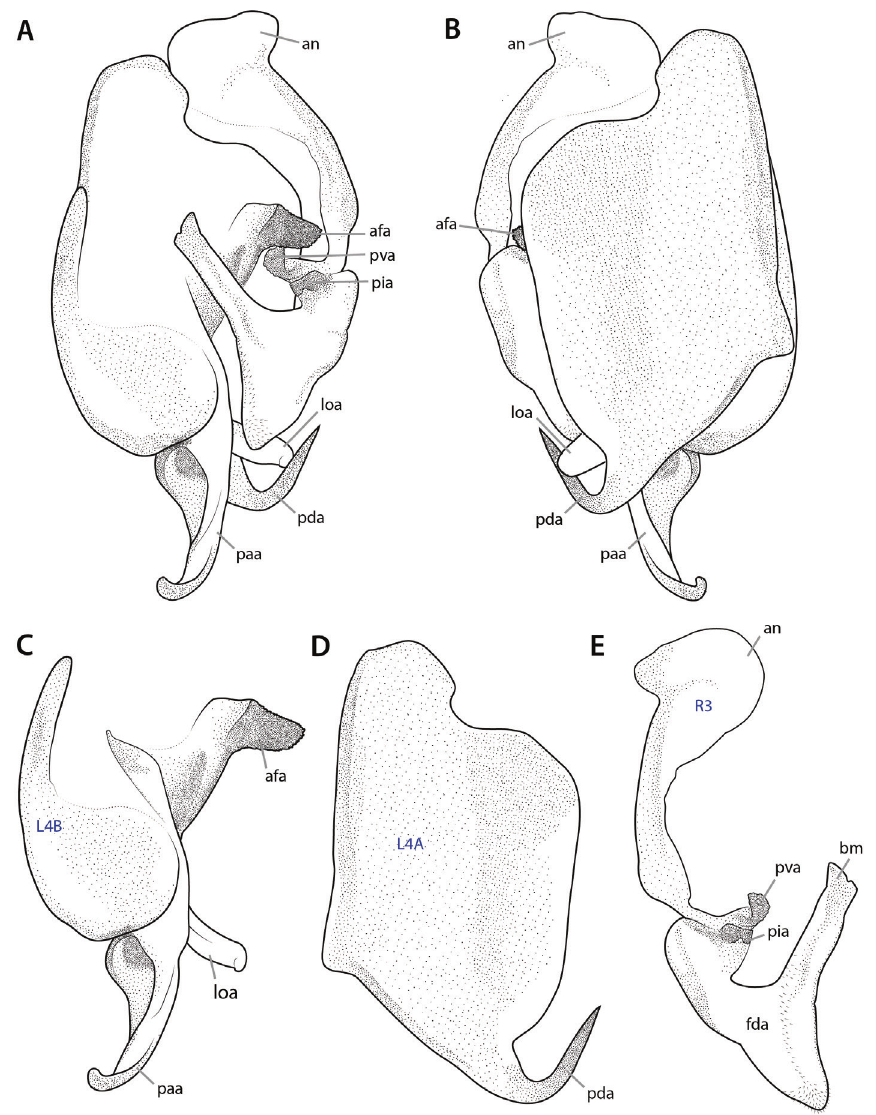
Figure 13. Annotated illustrations of Sphodromantis sp. male genitalia for taxonomic use. Intact genital complex A dorsal view B ventral view. Disarticulated genital complex to isolate the individual phallom- eres C – E : C left phallomere (of the left phallic complex), dorsal view D ventral phallomere (of the left phallic complex), dorsal view E right phallomere, ventral view. Blue text refers to major sclerotizations. Abbreviations: afa = anterior process (left phallomere); an = anterior extension of sclerite R3 (anterior apodeme); bm = dextral extension (right phallomere); fda = main posterior lobe (right phallomere); L4A = sclerite extending over the ventral wall (left phallomere); L4B = sclerite extending over the dorsal wall (left phallomere); loa = posteromesal (left phallomere); paa = posterior process (left phallomere); pda = posterior process (ventral phallomere); pia = process posterolateral to pva (right phallomere); pva = pro- cess anteromesal to pia (right phallomere); R3 = anteriorly extending sclerite (right